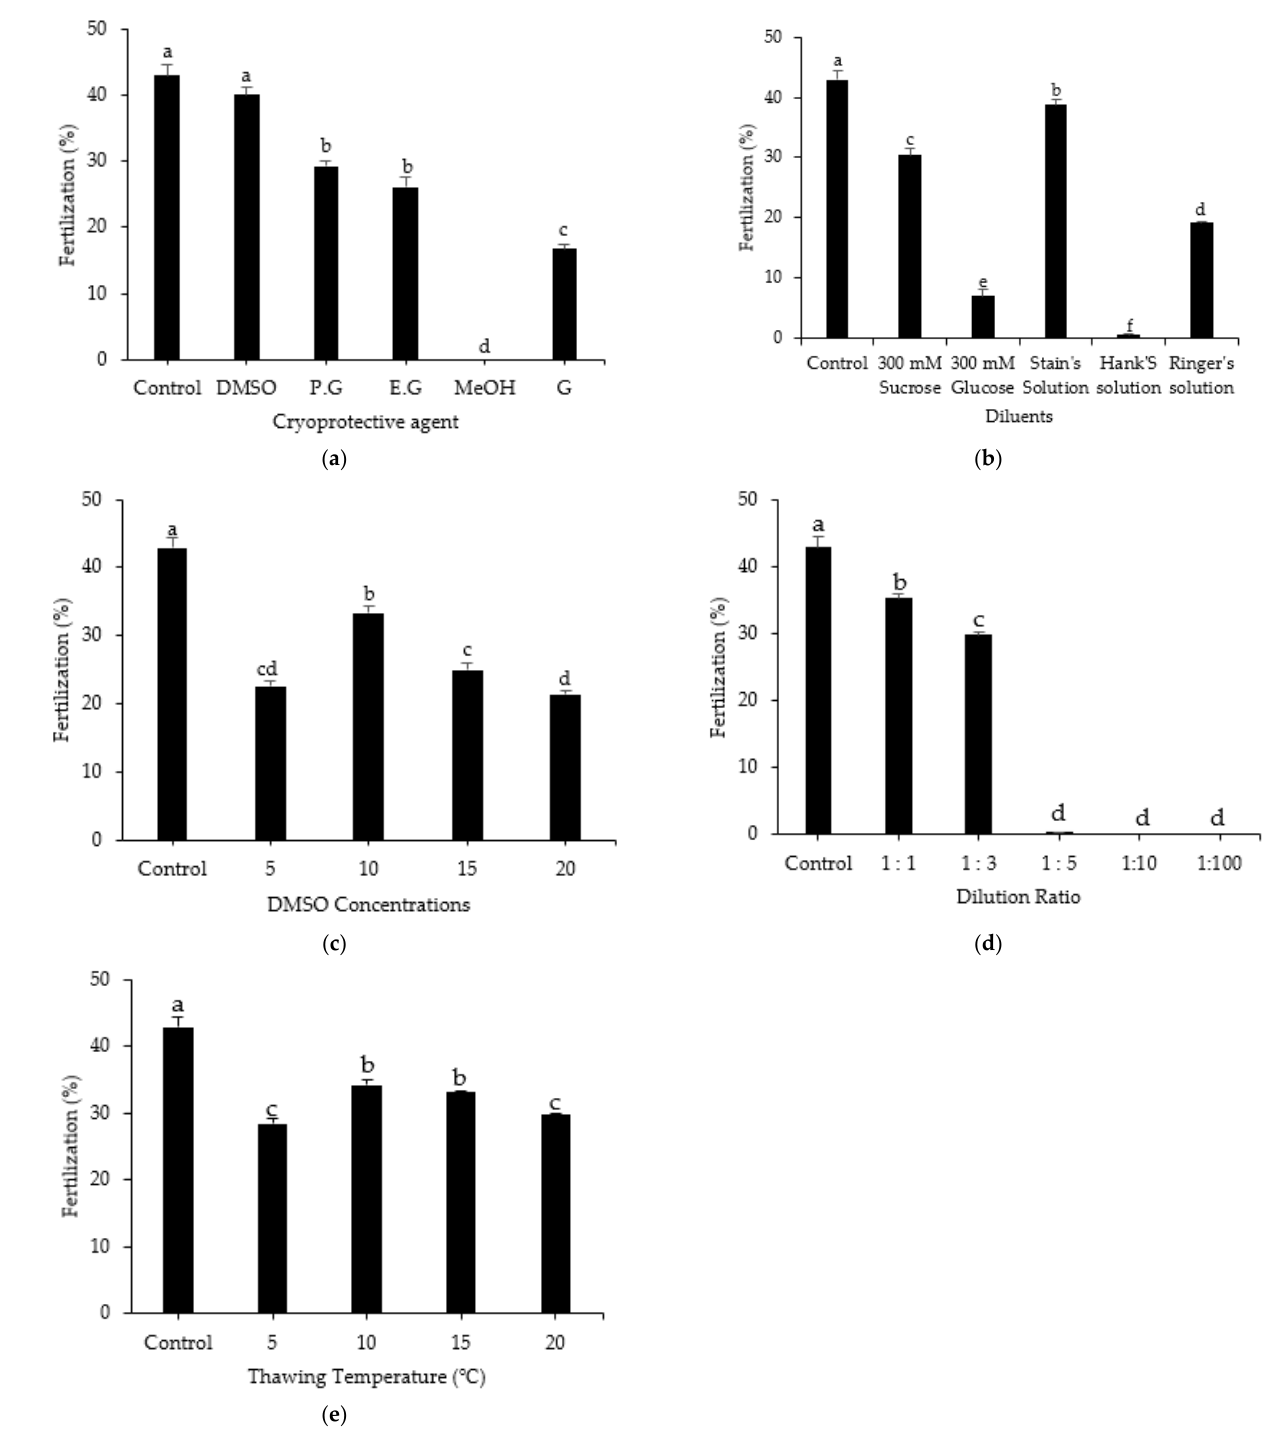
Figure 9. Fertilization rates of roughscale sole, Clidoderma asperrimum, eggs fertilized with fresh sperm and sperm cryopreserved with various treatment methods: ( a ) cryoprotective agent, ( b ) diluent, ( c ) DMSO concentration, ( d ) dilution ratio, and ( e ) thawing temperature. Different lowercase letters indicate significant differences among treatment methods ( p < 0.05). Control, fresh sperm.